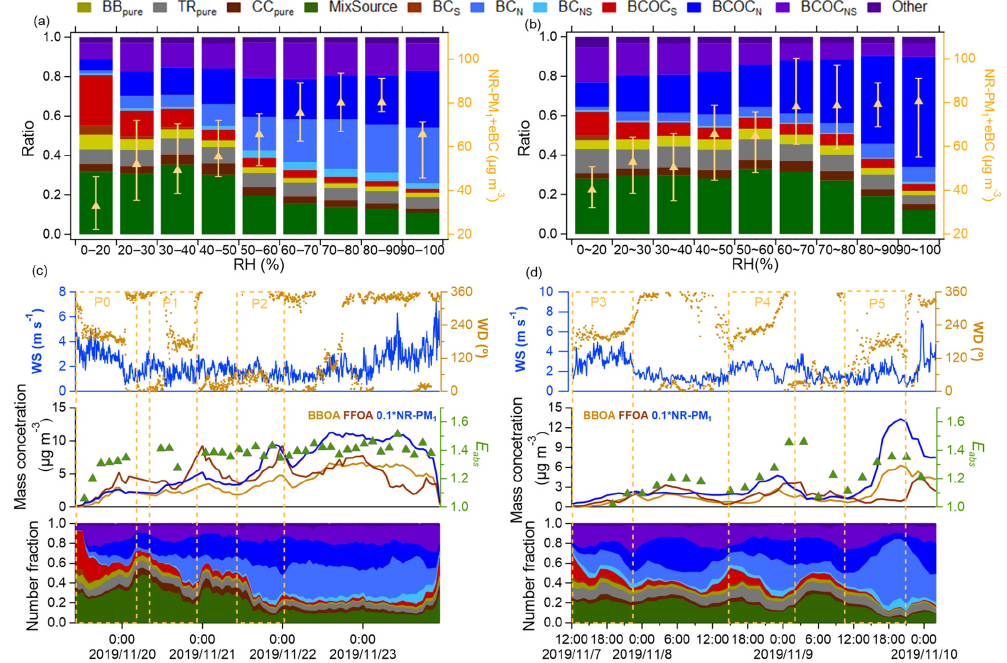
Figure 3. Variations of number fractions of BC-containing particle types with RH in (a) Beijing and (b) Gucheng. The bottom and top error bars represent the 25th and 75th percentiles. Temporal variations of wind speed (WS), wind direction (WD), E abs , number fractions of BC-containing particle types, and mass concentrations of species during pollution of (c) Case 1 and (d) Case 2 in